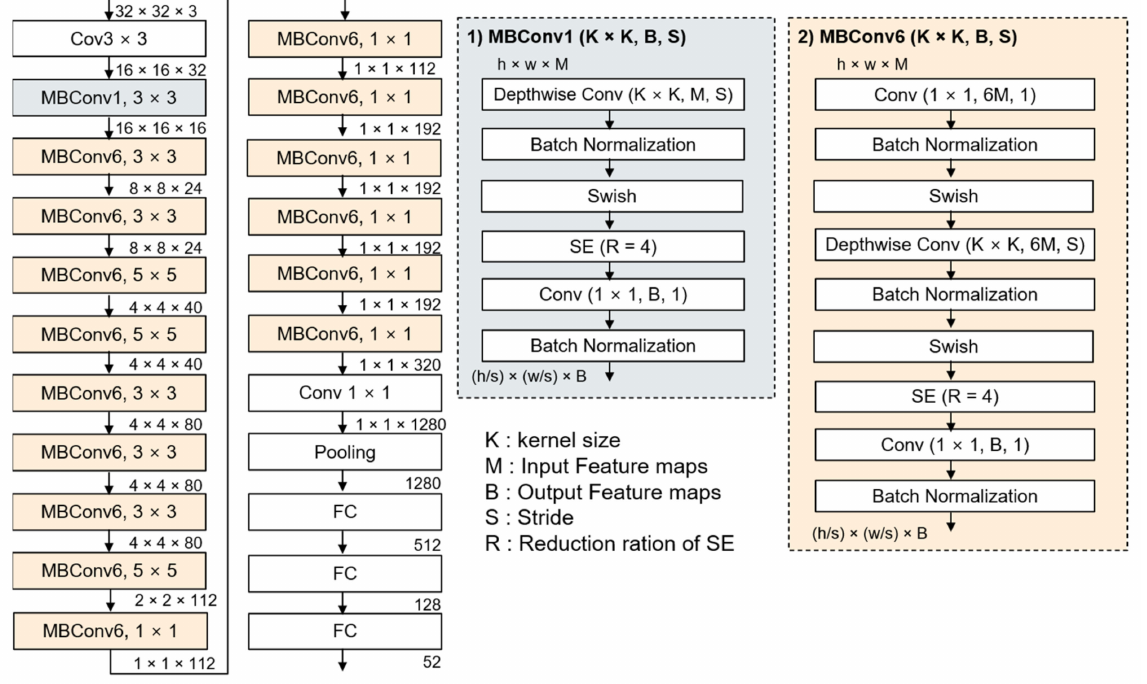
Figure 2. The structure of an EfficientNetB0 model with the internal structure of MBConv1 and MBConv6. Compared to MBConv1, MBConv6 has three layers at the top. The number of feature maps as the output is